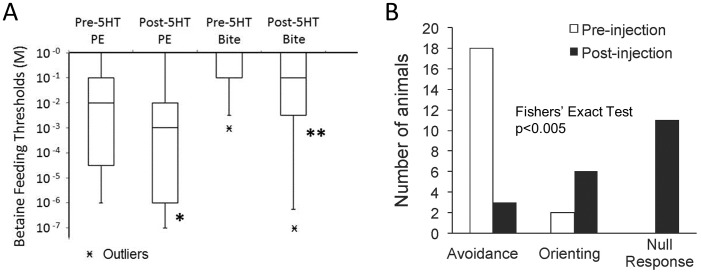
5-HT injections reduced feeding thresholds, suppressed avoidance, and promoted orienting turn responses to a noxious stimulus in intact animals.A. Injection of 23 animals with 5-HT (1–2.5 µM final hemolymph dilution) significantly reduced median feeding thresholds to betaine measured 12 minutes later (Wilcoxon matched-pairs signed-ranks tests, PE: W = −28, *p<0.02; Bite: W = −36, **p<0.01). Control saline injections were ineffective. B. Responses to noxious unilateral taurine application (10−2 M) to the tentacle/oral veil were compared before and after 5-HT injection to an estimated final hemolymph concentration of 2.5 µM. Among 20 animals tested, 18 initially showed avoidance and 2 animals showed orienting responses to taurine application. 12 minutes after 5-HT injection, avoidance was replaced by null responses in 11 animals and orienting turns were observed in 6 (p<0.005, Fishers' Exact Test); only 3 animals continued to show avoidance.